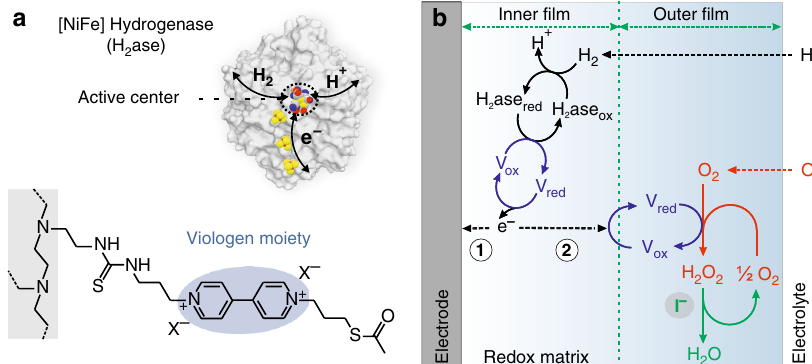
Fig. 1 Redox matrices for the protection of O 2 -sensitive catalysts. a Structure of the [NiFe]-hydrogenase and the viologen-modi fi ed polymer (polyethylenimine backbone). b Proposed mechanism for protection from O 2 . The hydrogenase catalyzes the reversible oxidation of H 2 in the inner parts of the fi lm and generates electrons that are transferred to the electrode via the viologen ( V red / V ox ) moieties (pathway 1) which produces the catalytic current when an oxidative potential is applied to the electrode. In addition, the presence of O 2 in the electrolyte creates an oxidative driving force that diverts some of the electrons towards the electrolyte/ fi lm interface (pathway 2) where the viologen moieties act as catalysts for O 2 reduction, thus protecting the catalyst in the inner fi lm domain but also producing H 2 O 2 . Iodide catalyzes the subsequent H 2 O 2 dismutation to H 2 O and half a molecule of O 2 , which is further reduced by the